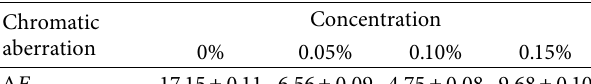
Table 4: Difference before and after the aging of silicone rubber specimens coated with nano-TiO 2 with different concentrations of silicon and aluminum ( F � 15623.69, P < 0 .